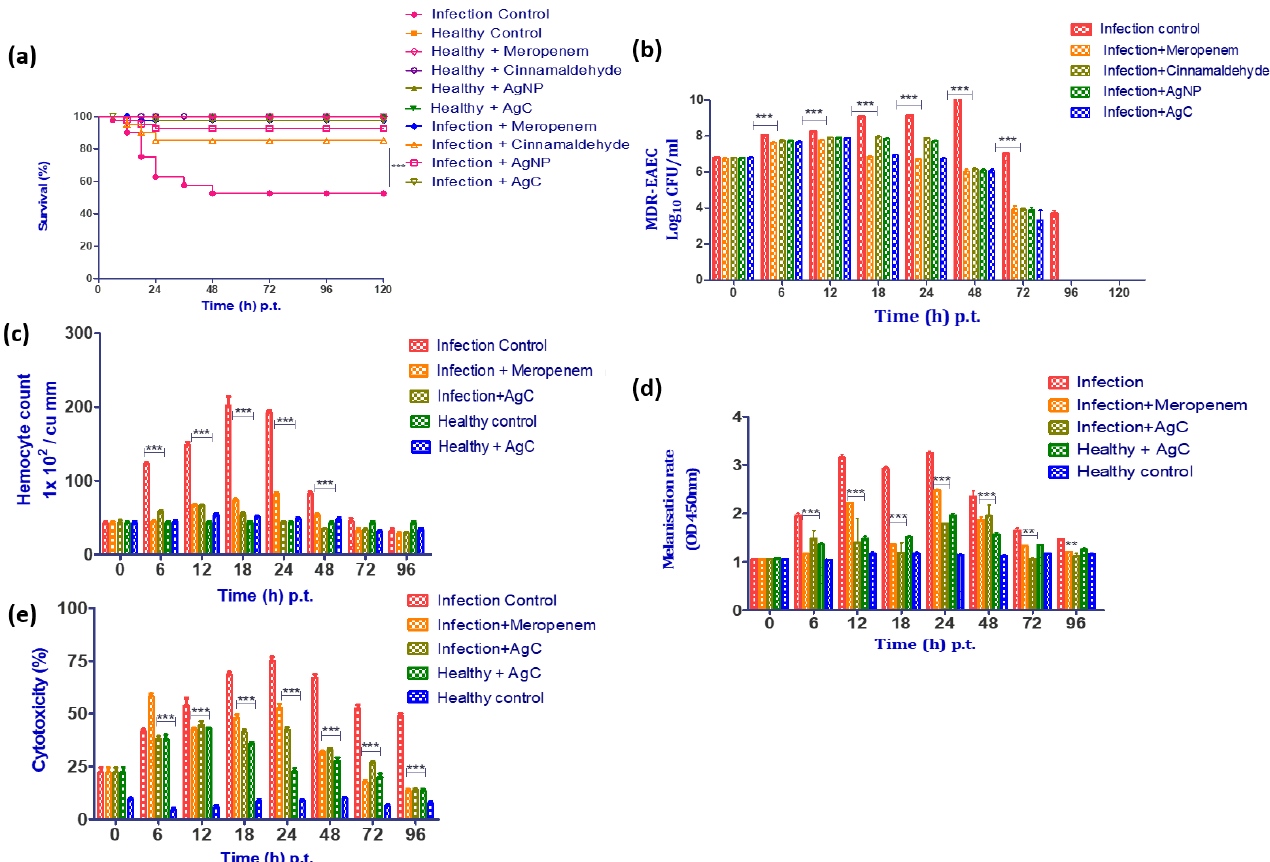
Figure 5. In vivo assays using G. mellonella model. Survival plot ( a ), MDR-EAEC counts ( b ), haemo- cyte density ( c ), melanization rate ( d ) and LDH cytotoxicity assay ( e ) of G. mellonella larvae infected with LD 50 dose (10 6 CFU/ larvae) of MDR-EAEC isolates treated with MBC dose of cinnamalde- hyde, AgNPs and AgC 1 h p.i., keeping respective controls. MDR-EAEC counts were expressed as log 10 CFU/mL of haemolymph on EMB agar plates supplemented with ampicillin (100 µ g/plate), haemocyte density as cells/mL of haemolymph, melanization rate by monitoring absorbance at 450 nm, and LDH cytotoxicity assay as the cytotoxicity (%) of larval haemolymph. Data expressed as the mean ± standard deviation of three independent experiments. ** and *** indicates ( p < 0.01) and ( p < 0.001), respectively and is statistically significant in comparison to infection